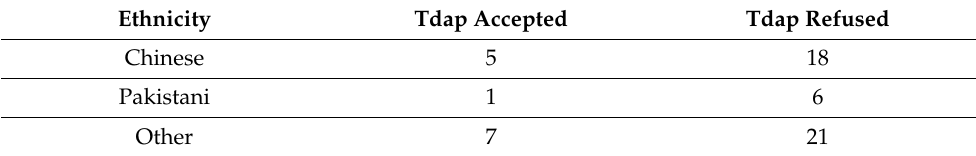
Table 11. Tdap refusal and acceptance according to different foreign